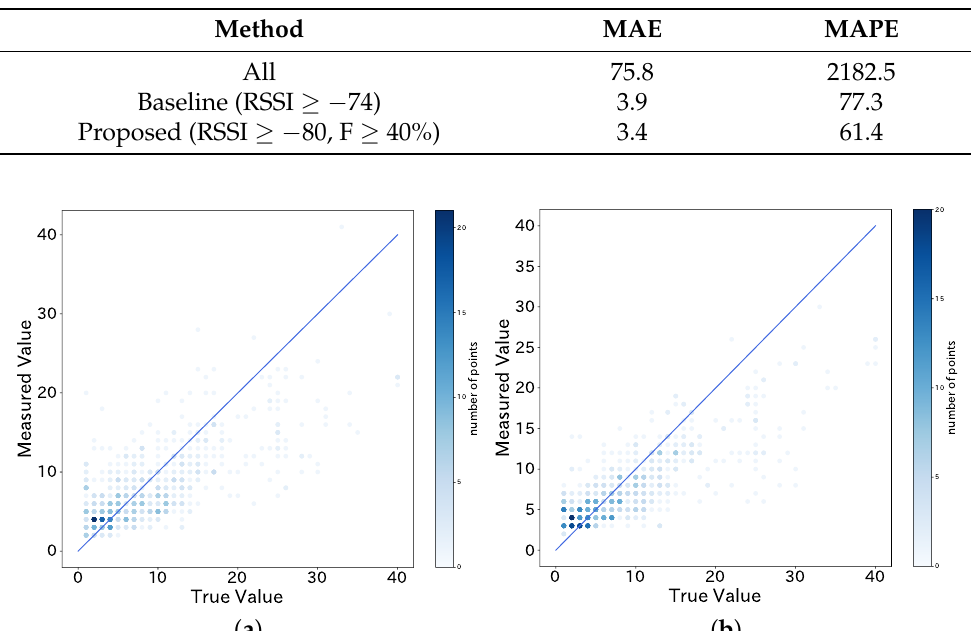
Table 4. Results of threshold estimation.